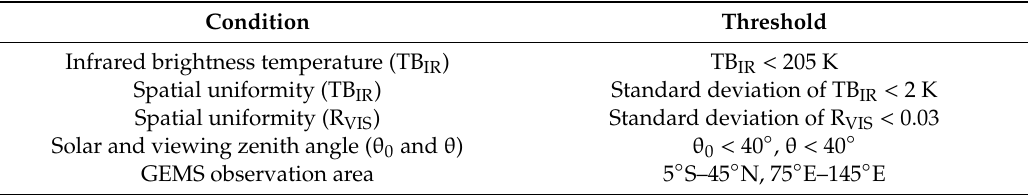
Table 2. DCC detection